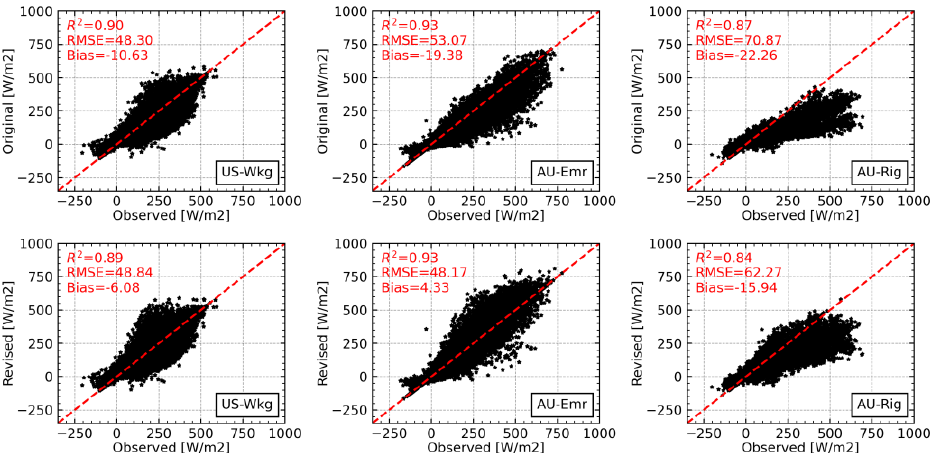
Figure 14. Relationship between the observed and simulated sensible heat flux by the original and the revised parameterization at grassland sites.